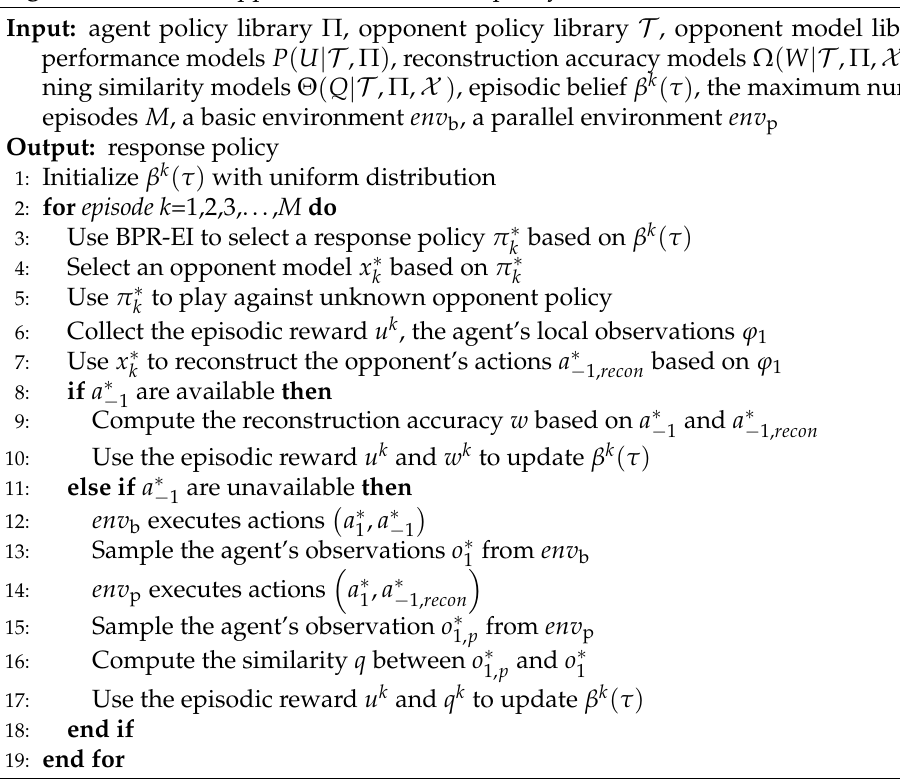
Algorithm 2 Online opponent detection and policy